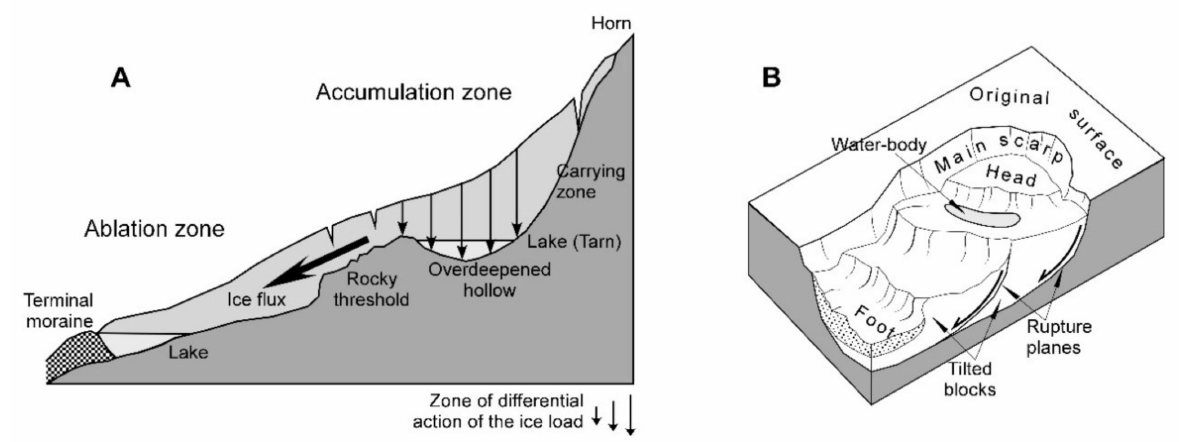
Figure 6. Conceptual sketch of the formation models by which the water-bodies of the Sierra Nevada can be categorized. ( A ) Alpine glacier processes, such as overdeepening and moraine dams. The lakes form when ice melts. The carrying zone is where the bedrock is removed by the action of ice and gravity and is considered the most important glacial erosive process ([60] and the references therein). ( B ) Landslides are represented by the most general case and shows some associated